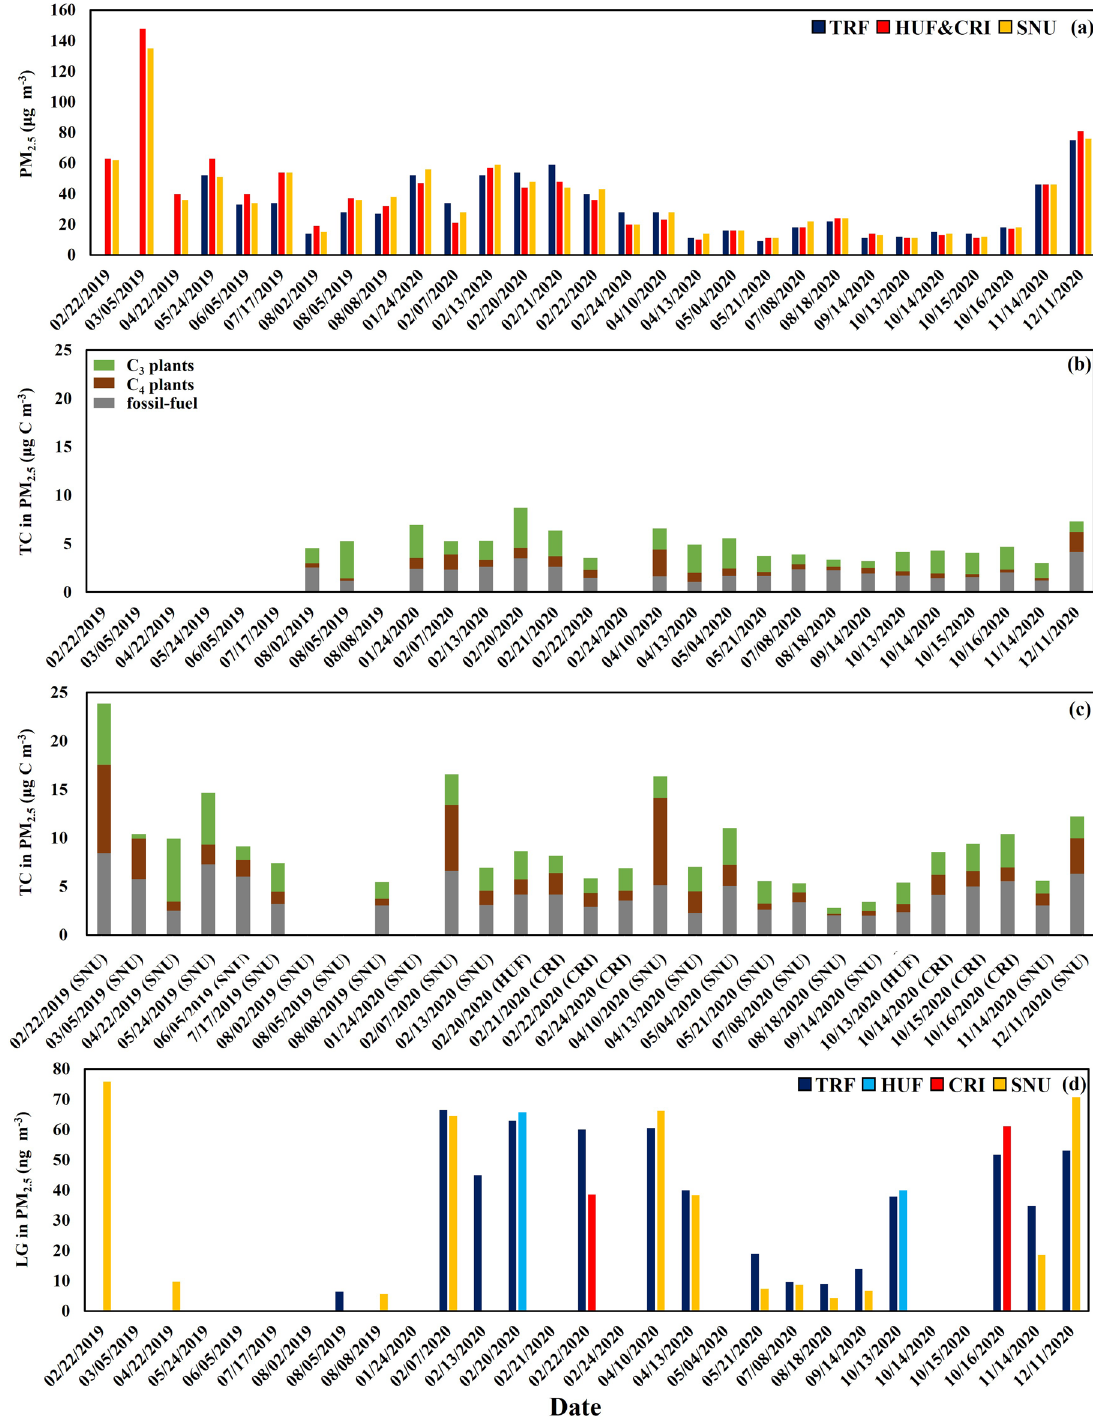
Figure 3. ( a ) The concentrations of PM 2.5 (μg m −3 ) at the national PM 2.5 monitoring sites near SNU, HUF&CRI (one site; section "PM 2.5 monitoring data in South Korea"), and TRF. ( b ) The concentration (μg C m −3 ) of TC in PM 2.5 at TRF. ( c ) The concentrations of TC in PM 2.5 at SNU, HUF, and CRI. The green, brown, and grey bars in ( b ) and ( c ) represent carbon derived from C 3 plants, C 4 plants, and fossil fuel, respectively. ( d ) The concentration (ng m −3 ) of